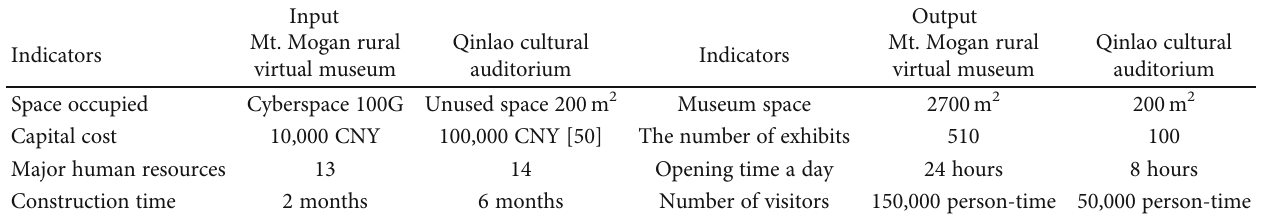
Table 3: The input-output comparison of the Mt. Mogan rural virtual museum and the Qinlao cultural auditorium.